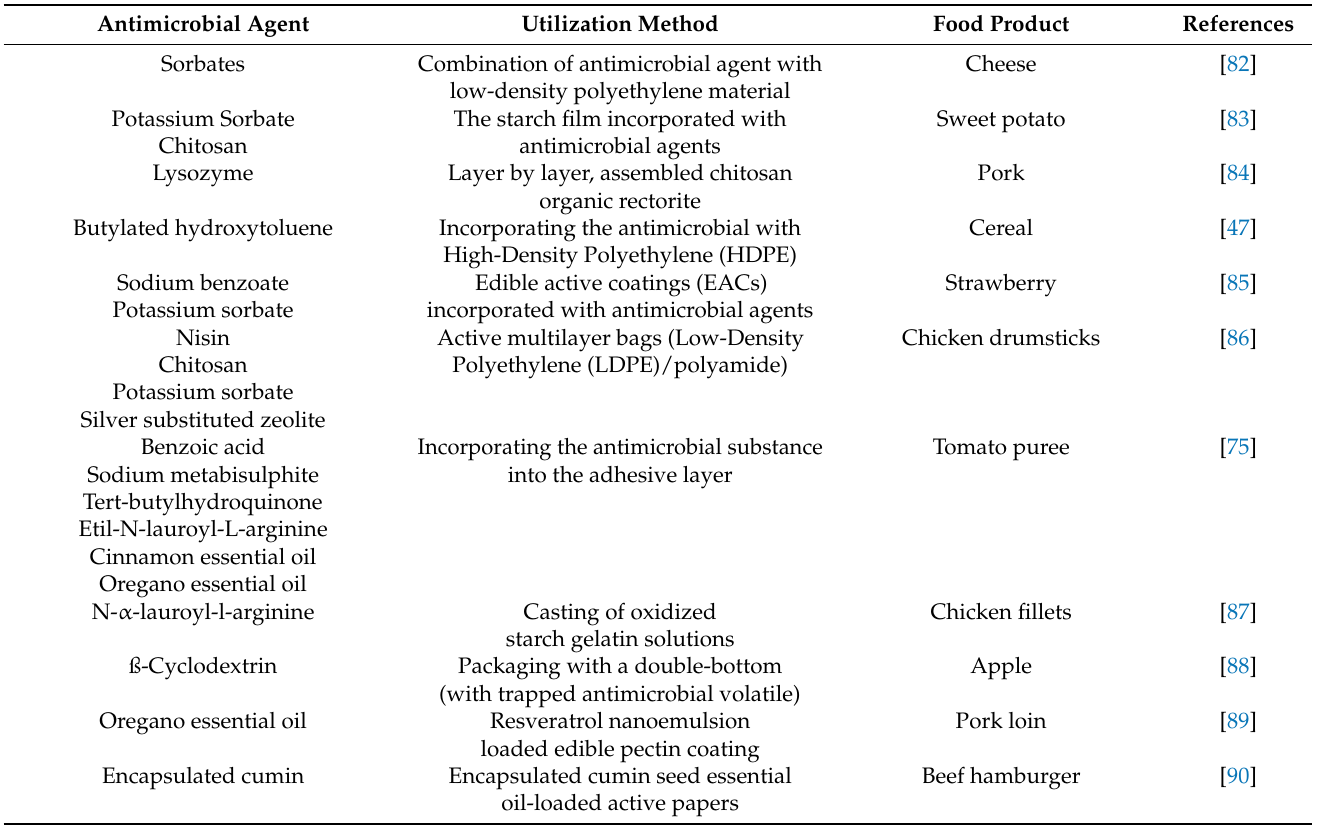
Table 1. Overview of the use of several antimicrobial agents in various products. Antimicrobial